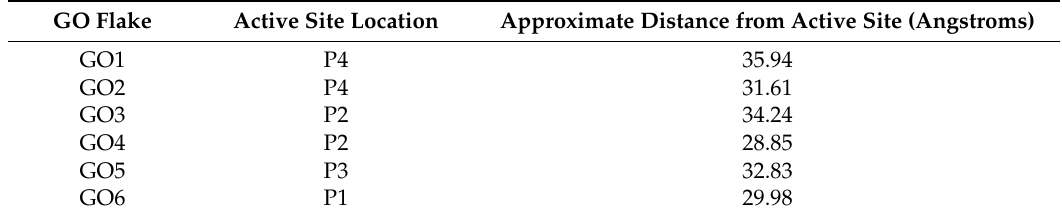
Table 3. Initial positioning of the GO